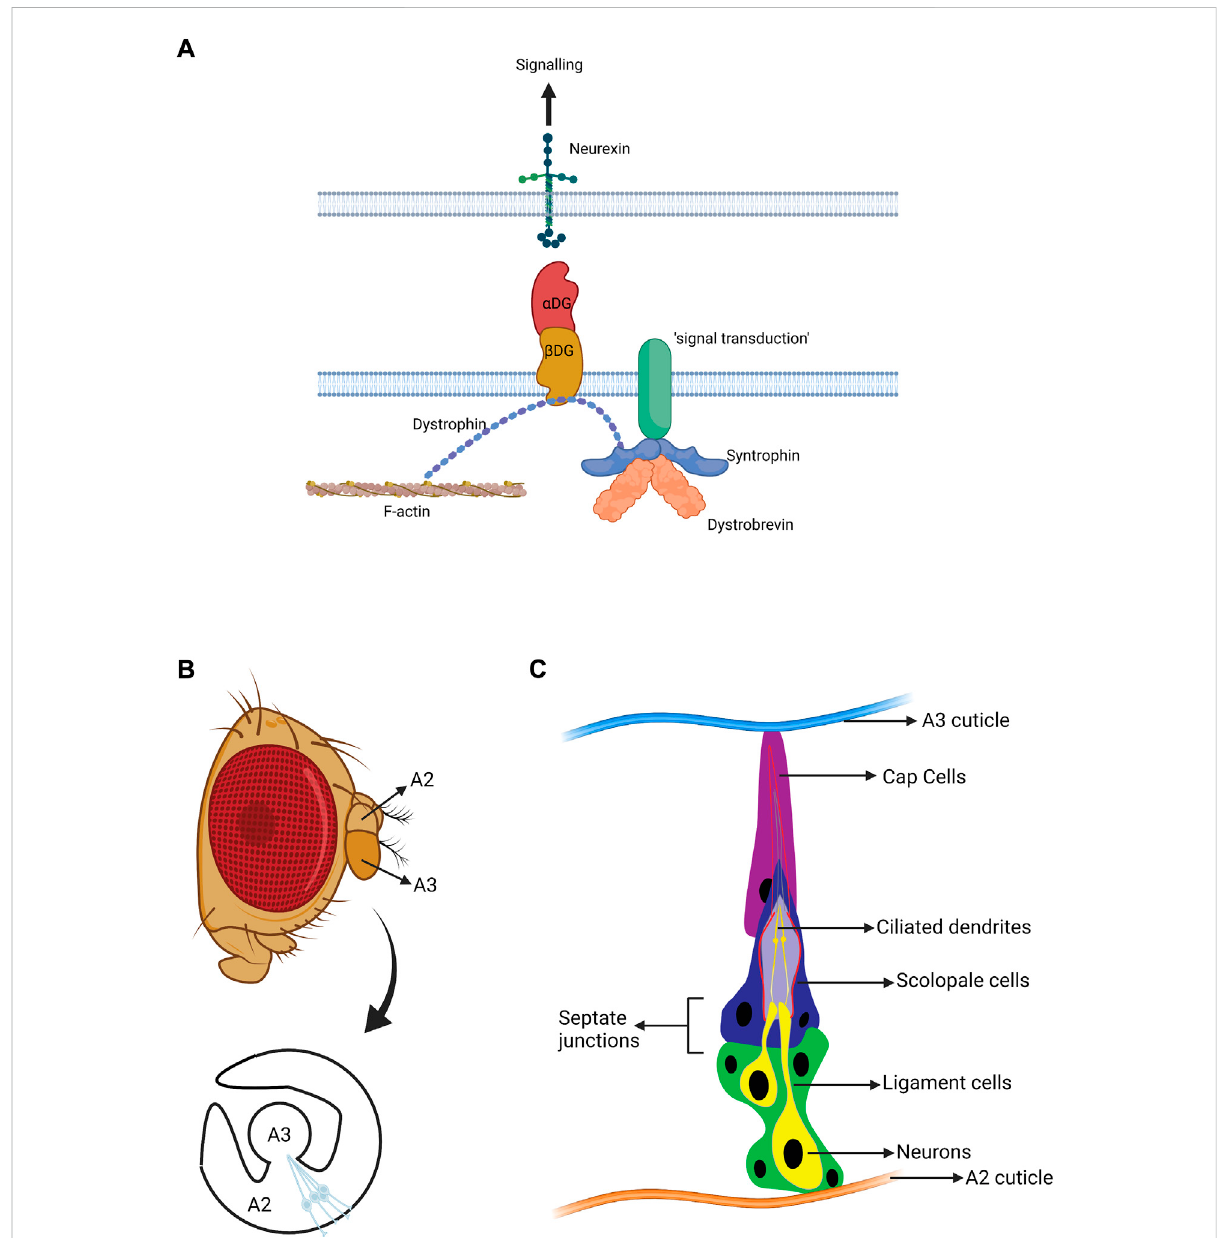
FIGURE 1 Structure of the Drosophila auditory organ . (A) Schematic diagram of the DGC. The major roles of the DGC are structural and organisation of signalling. Dystobrevin speci fi cally participates in recruiting varioussignal transductionmolecules. (B) A lateral view of an adult Drosophila head with a magni fi ed view of antennal segments A2 and A3. The fl y ’ s ear or auditory organ (Johnston ’ s organ, JO) is located in A2 and consists of functional units called scolopidia. These are attachedto thecuticle ofA2 on one side, and the A2/A3 jointon the other. The scolopidial area is highlighted, and one scolopidium is magni fi ed. (C) Cellular components of an individual scolopidium. Each scolopidium is attached to the antenna cuticle by a cap cell (magenta) and ligament cells (green). The ligament cells ensheath two to three mechanosensory neurons (yellow). The ciliary dendrites of the neurons are enclosed by an actin-rich structure generated by the scolopale cell (dark blue). Scolopale cells form septate junctions with the ligament and cap cells at the basal and apical ends of the scolopidium, respectively, ensuring the formation of an enclosed space to maintain the K + -rich lymph bathing the cilia. Approximately 225 scolopidia are located in JO. (B, C adapted from Li T. et al., 2018. Figures made in